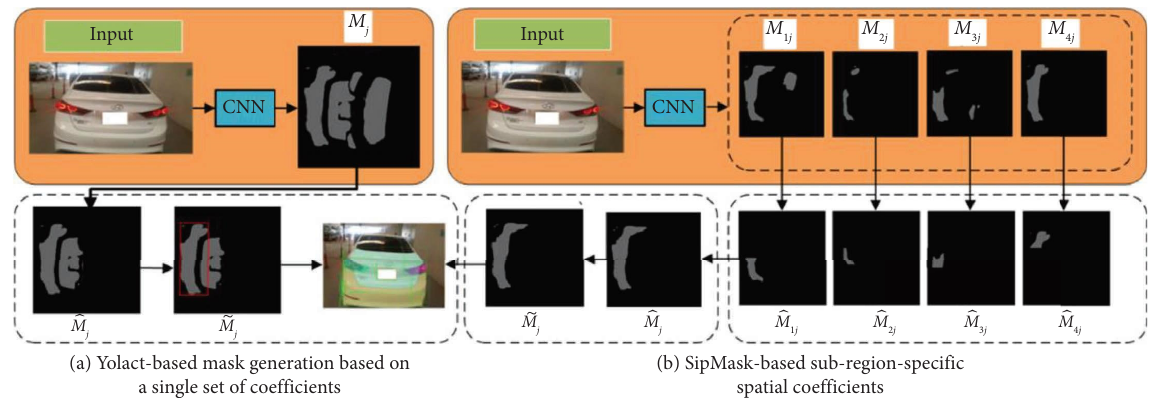
Figure 6: A YOLACTto SipMask comparison with (a) a single coefcient set (nonspatial) example compared against (b) subregion-specifc spatial coefcient generation using